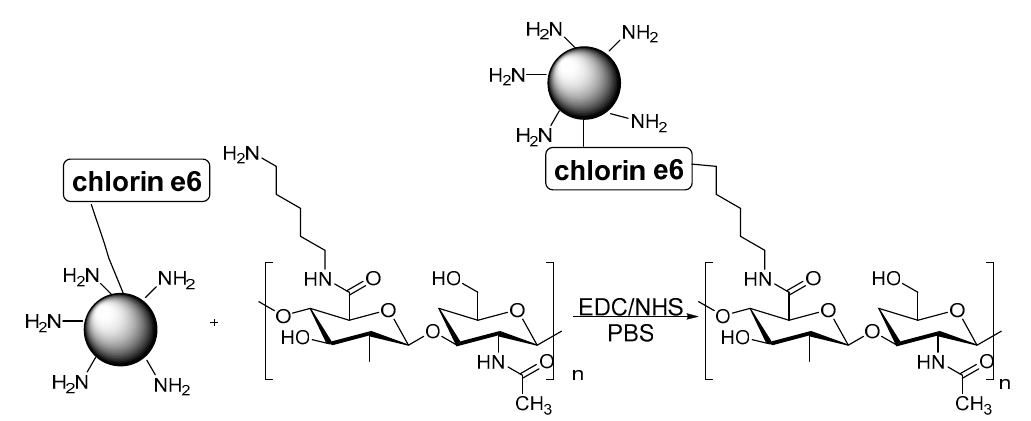
Figure 9. Bioconjugation of a chlorin-e6-functionalized carbon dot and diaminohexane-modified hyaluronate via the 1-ethyl-3-(3-dimethylaminopropyl)carbodiimide- N -hydroxysulfosuccinimide sodium (EDC-NHS) methodology.